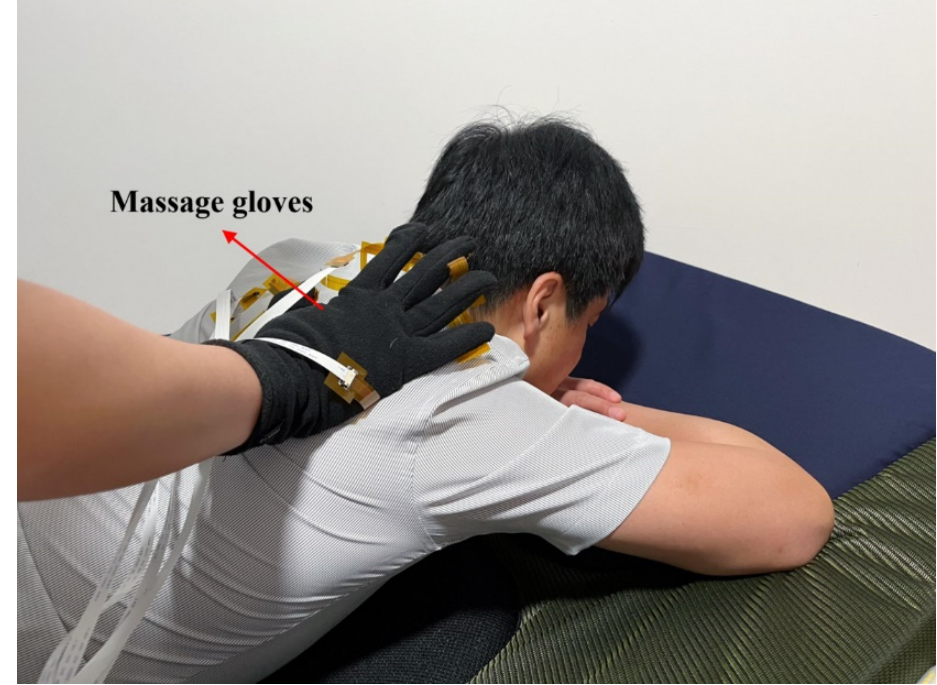
Figure 3. Diagram of the massage data collection process.